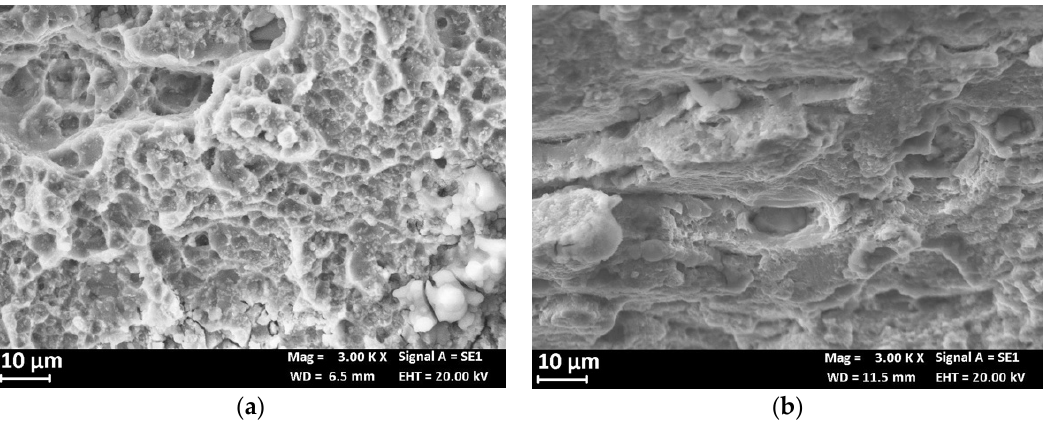
Figure 19. ( a ) Particular of the mixed ductile/brittle fracture zone and ( b ) of the ductile shearing final rupture.